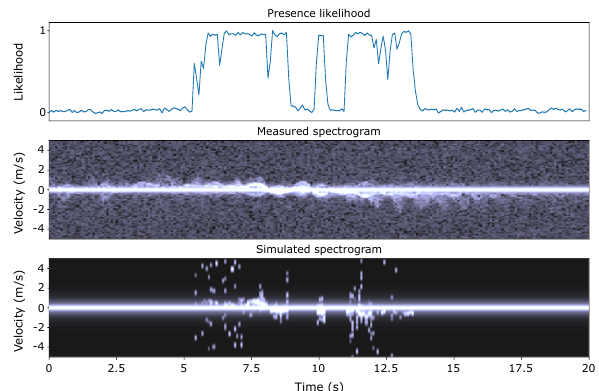
Figure 6. Particle filter results on the measurement of a person trying to find his way through glycerine based smoke, first away from the sensor and then